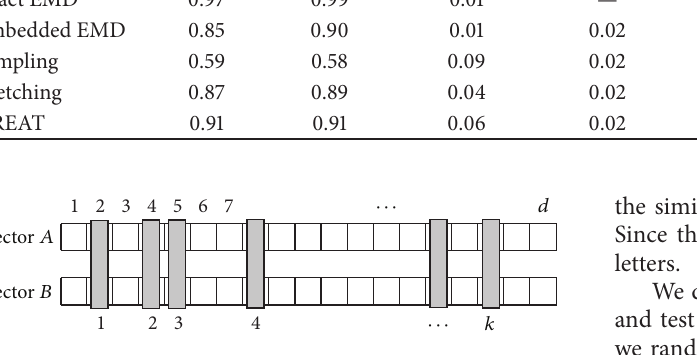
Figure 5: Sampling method on vector A and vector B.